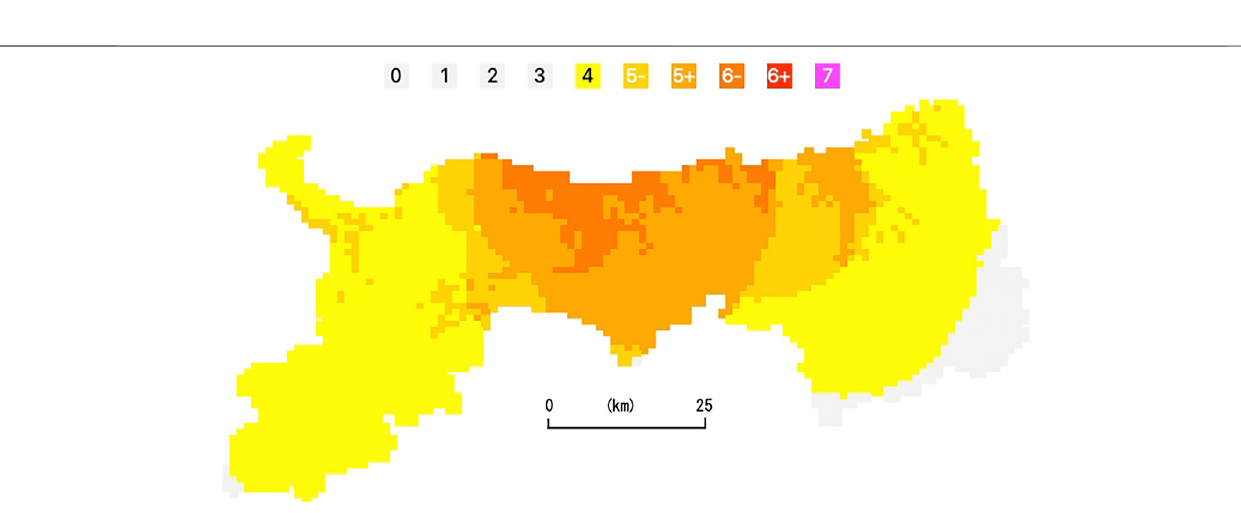
Frontiers in Earth Science |